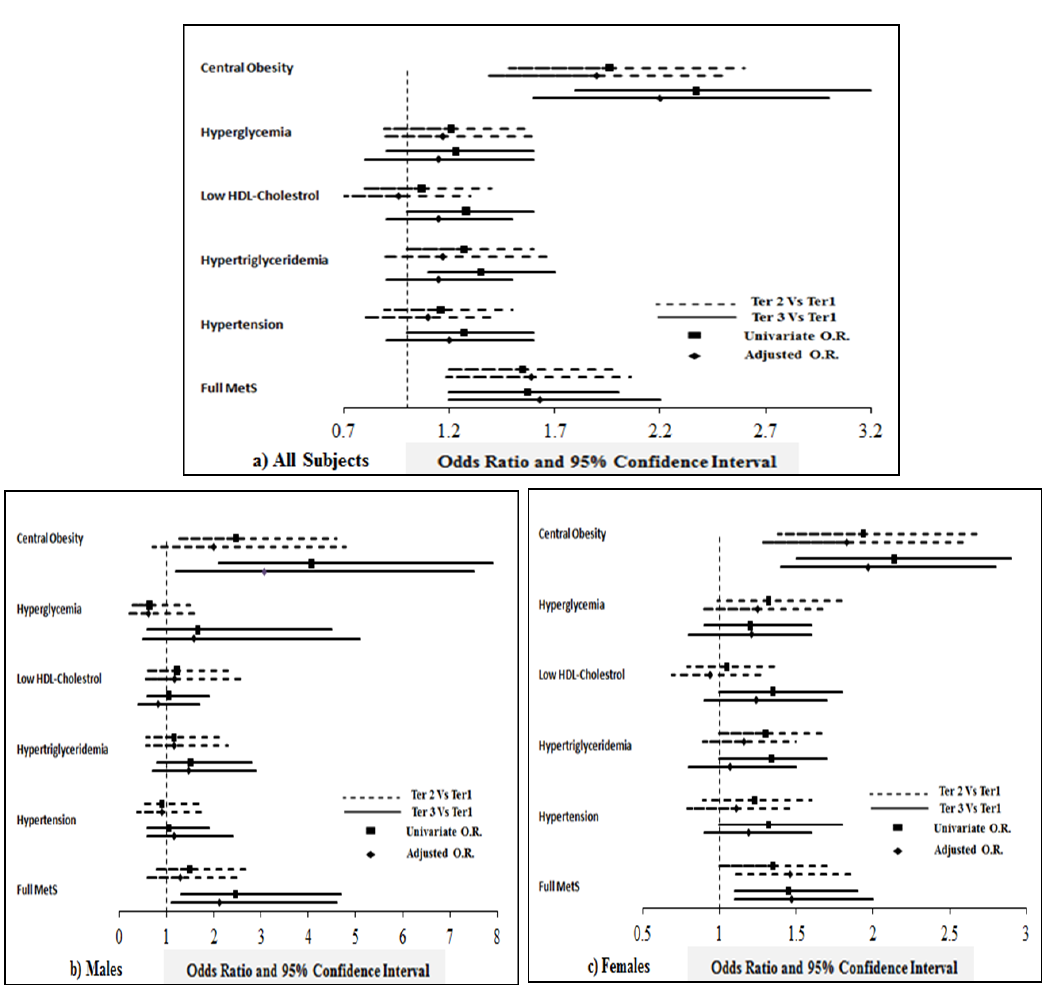
Figure 2. Odds of having full MetS and its components in individuals with higher tertiles of T-score (spine) compared with lowest tertile. Note: The figure shows the odds ratio (OR) and 95% confidence interval representing odds of having different components of metabolic syndrome at higher tertiles of T-score (spine) compared to the lowest tertile. The data was generated by multinomial regression taking T-score tertiles as dependent variables and MetS and its components (present versus absent) as factors. Unadjusted OR; and OR adjusted for age, BMI and risk factors associated with bone loss like family history of diabetes, osteoporosis, arthritis, whether or not suffering from T2DM, thyroid disease, history of broken bones, etc., are represented here.